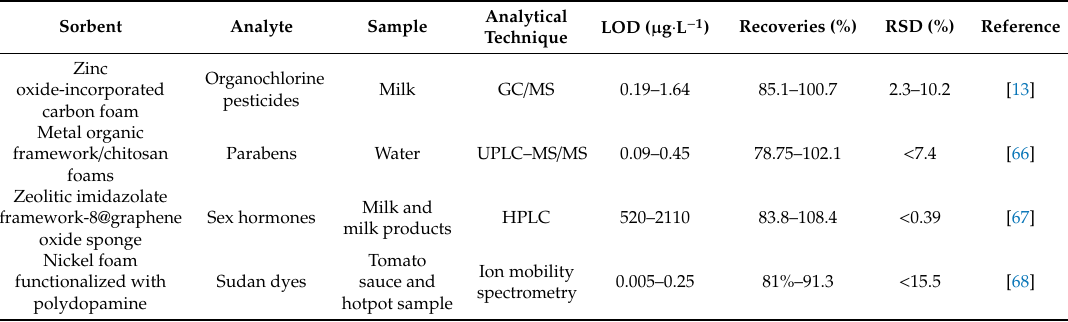
Table 4. Analytical methods developed based on carbon foams with